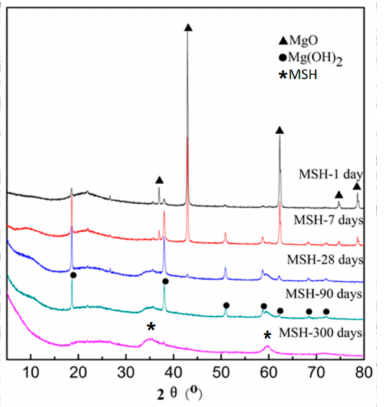
Figure 1. X-Ray diffraction (XRD) results of magnesium silicate hydrate (MSH) samples after curing for 1, 7, 28, 90 and 300